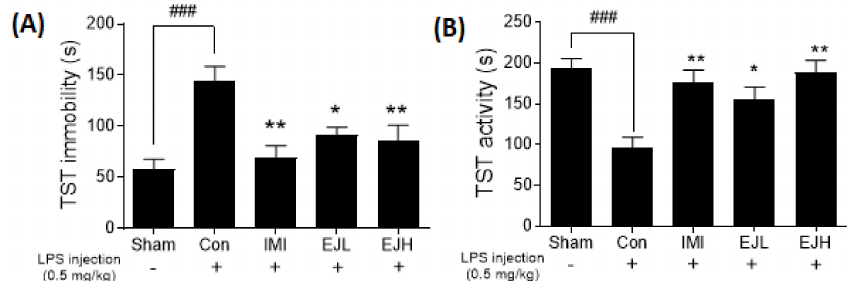
Figure 5. E ff ect of EJE on the tail suspension test in LPS-induced depressive mice. LPS-injected mice had significantly increased immobility and decreased activity, while EJ extract treated-mice showed significant improvements, with a reduced immobility time (s) ( A ) and increased activity time (s) ( B ). Results are presented as mean ± SEM. TST, tail suspension test; EJE, E. japonicum extract; LPS, lipopolysaccharide; Con, control; IMI, imipramine 30 mg / kg; EJL, EJE 100 mg / kg; EJH, EJE 300 mg / kg.,